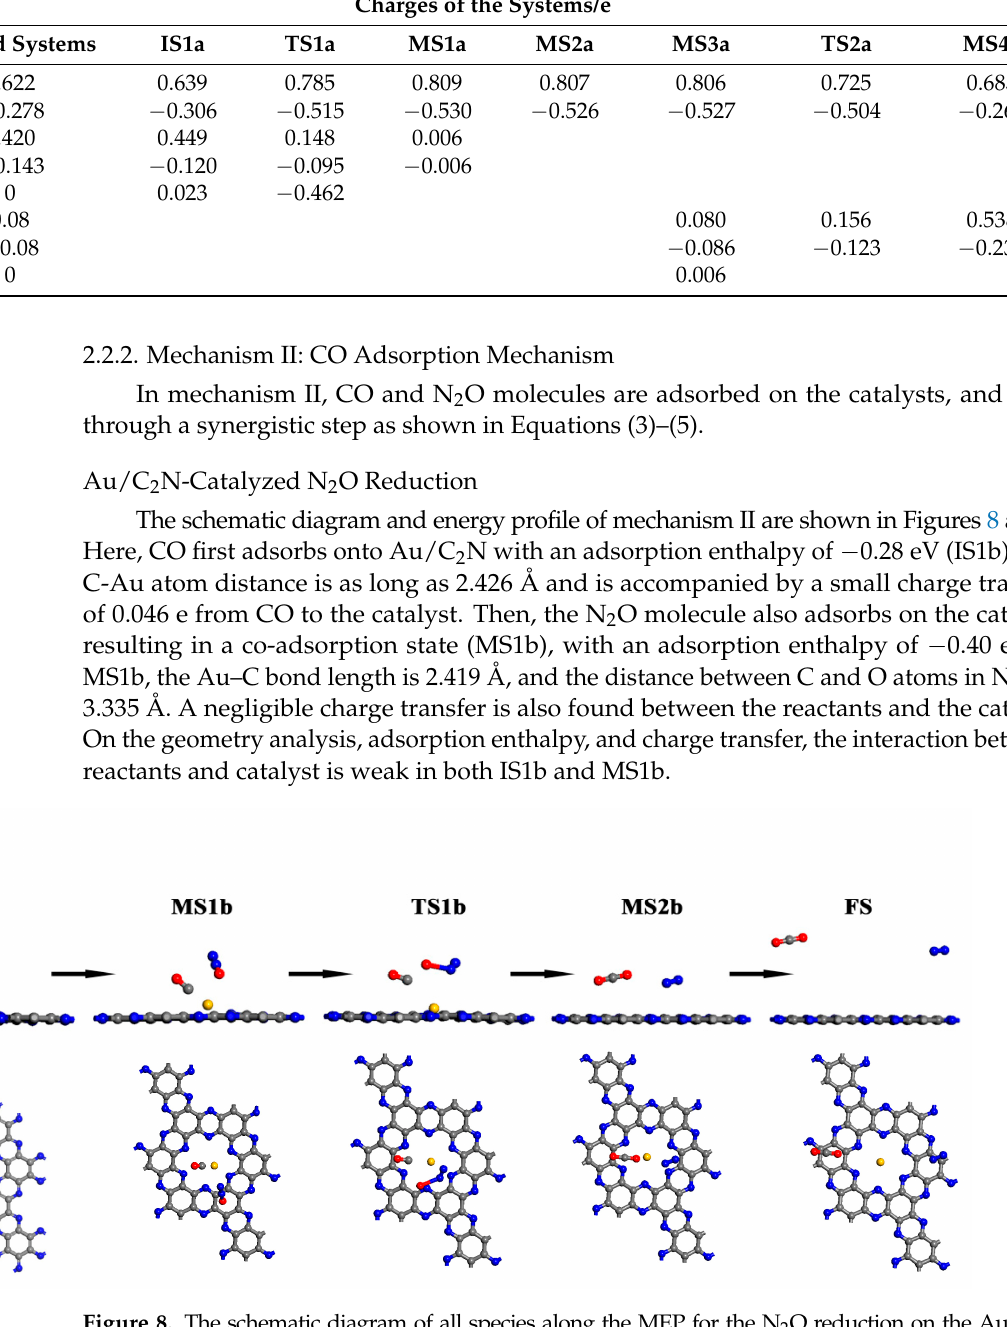
Figure 9. Energy profiles along the MEP for the N 2 O reduction via mechanism II. (R: M/C 2 N+N 2 O+CO, FS: M/C 2 N+N 2 +CO 2 .)